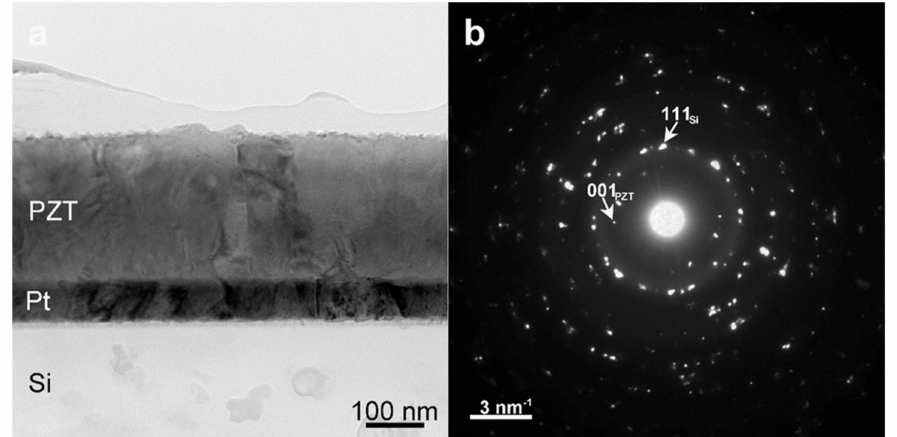
Figure 2. ( a ) TEM image at low magnification of the PZT/Pt/SiOx/Si structure and ( b ) the corre- sponding SAED pattern performed on area which include both the substrate and the thin films. See also Figure S1 in Supplementary Materials for the PZT layer deposited by sol-gel on STO